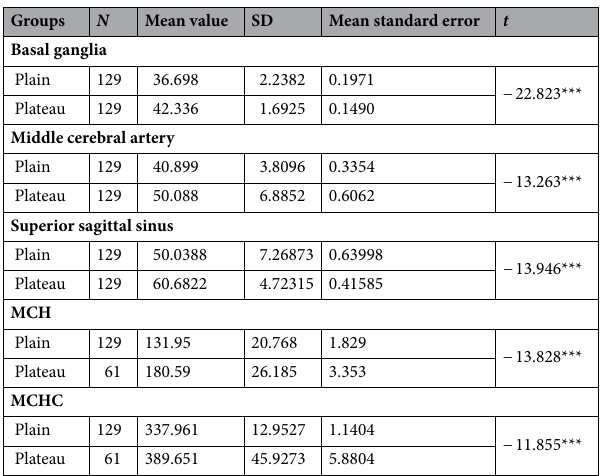
Table 1. The statistics of the following five parameters from both plateau and plain groups.